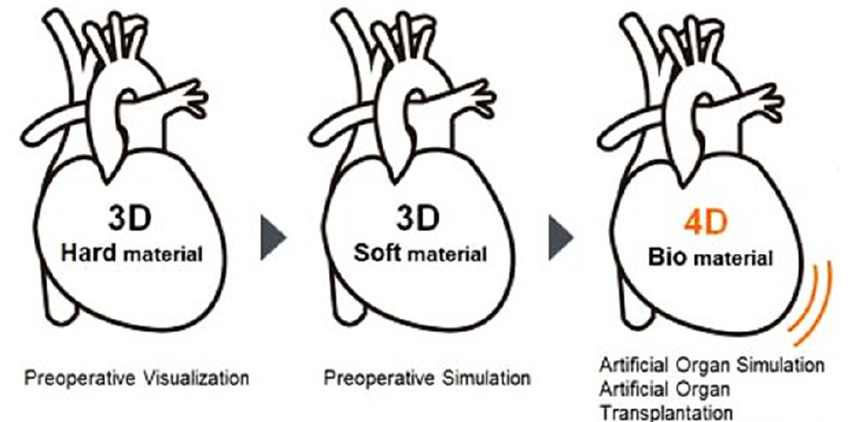
Figure 9. Evolution of 3D bioprinting.